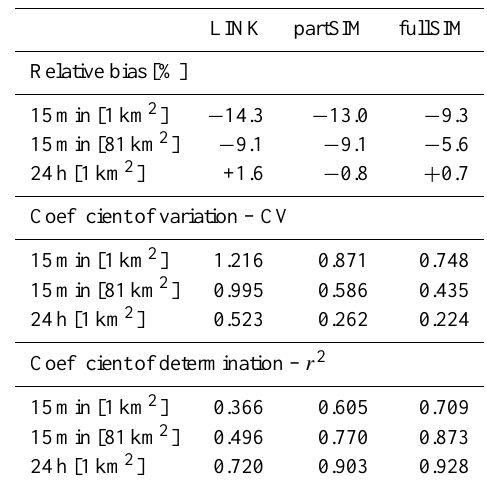
Table 1. Relative bias, and coefficients of variation and determi- nation for the three cases of spatiotemporal aggregation (15min [1km 2 ], 15min [81km 2 ], 24h [1km 2 ]), for the three sets of link measurements, i.e. the actual and both types of simulated link rain- fall depths (actual and 100% network